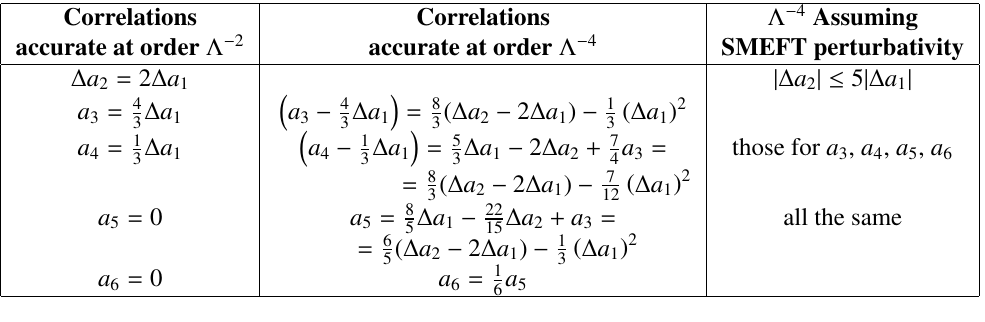
Figure 1. Correlations for the HEFT coe ffi - cients from Table 1 that need to be satisfied for SMEFT to be a valid EFT of the electroweak symmetry breaking sector. The solid diagonal is the correlation of order Λ − 2 , that becomes broadened as the indicated band (greenish on- line) at order Λ − 4 .